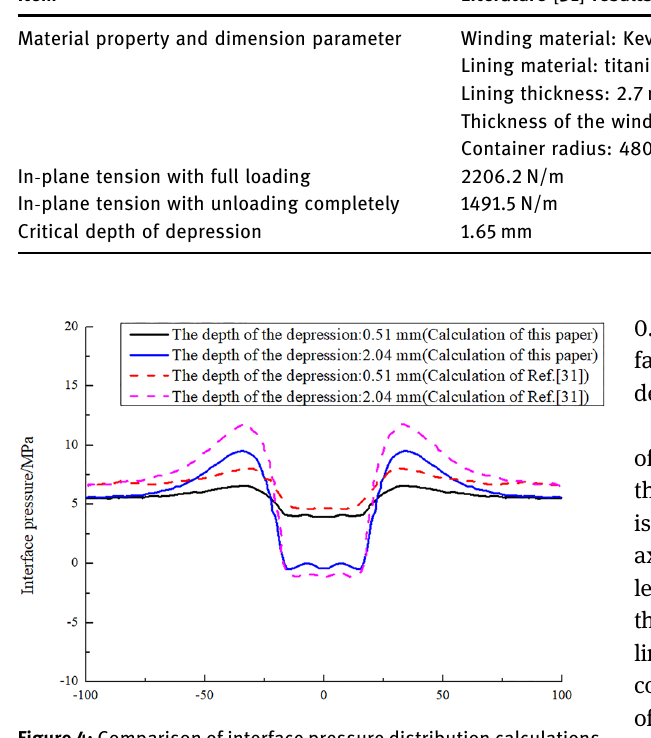
Table 1: Comparison between the calculation results of the literature [ 31 ] and results of veri fi cation examples in this article Item